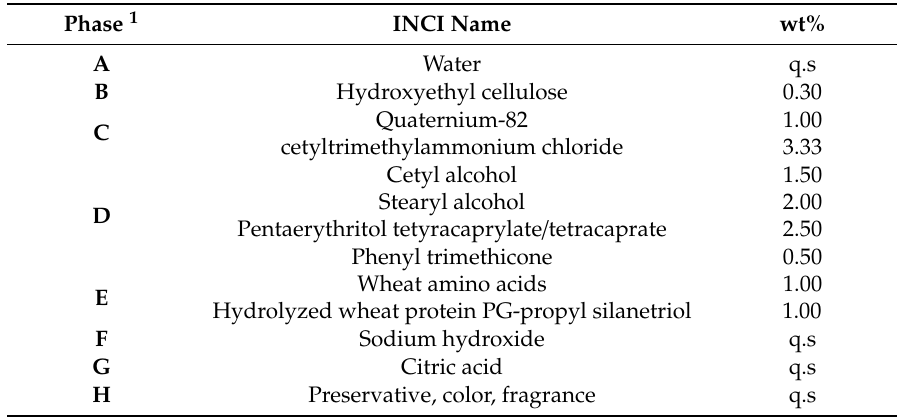
Table 1. Model composition of a hair conditioner according to [38]. q.s: quantum satis (the amount which is